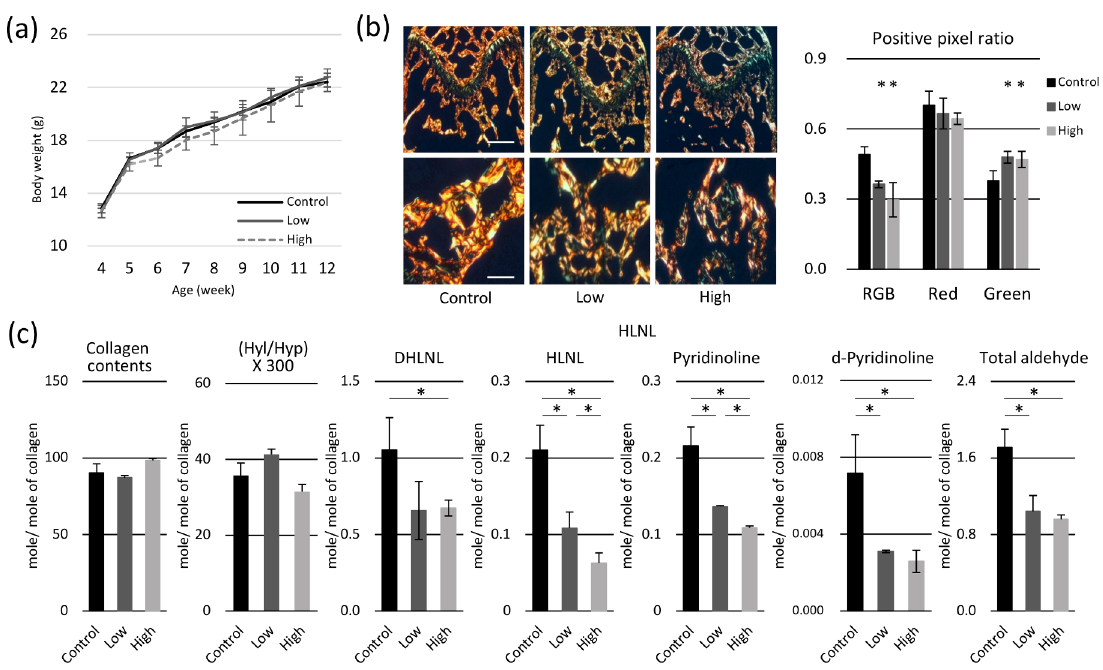
Fig 4. Effects of β -aminopropionitrile (BAPN)-containing diet on body weight, bone volume, and collagen cross-linking in mice. (a) The body weight of mice increased steadily throughout the experimental period, and no differences were observed between groups. (b) Histology of Picrosirius Red-stained samples at 12 weeks of age (after 8-week of the BAPN consumption) is shown. Under polarized light, positive pixel ratio of immature matrix (green) increased with BAPN administration, while that of mature matrix (red) did not change Bar: 200 μ m. (c) Collagen Cross-links were analyzed at 12 weeks of age (after 8-week of the BAPN consumption). Collagen content and hydroxylysine (Hyl)/hydroxyproline (Hyp) × 300 were not affected by BAPN, but dehydrodihydroxylysinonorleucine (DHLNL) and dehydrohydroxylysinonorleucine (HLNL) levels decreased in a dose-dependent manner. Pyridinoline, deoxypyridinoline, and total aldehyde contents were significantly reduced in mice fed with BAPN-containing diet. (cid:3) p < 0.05, compared to the control.